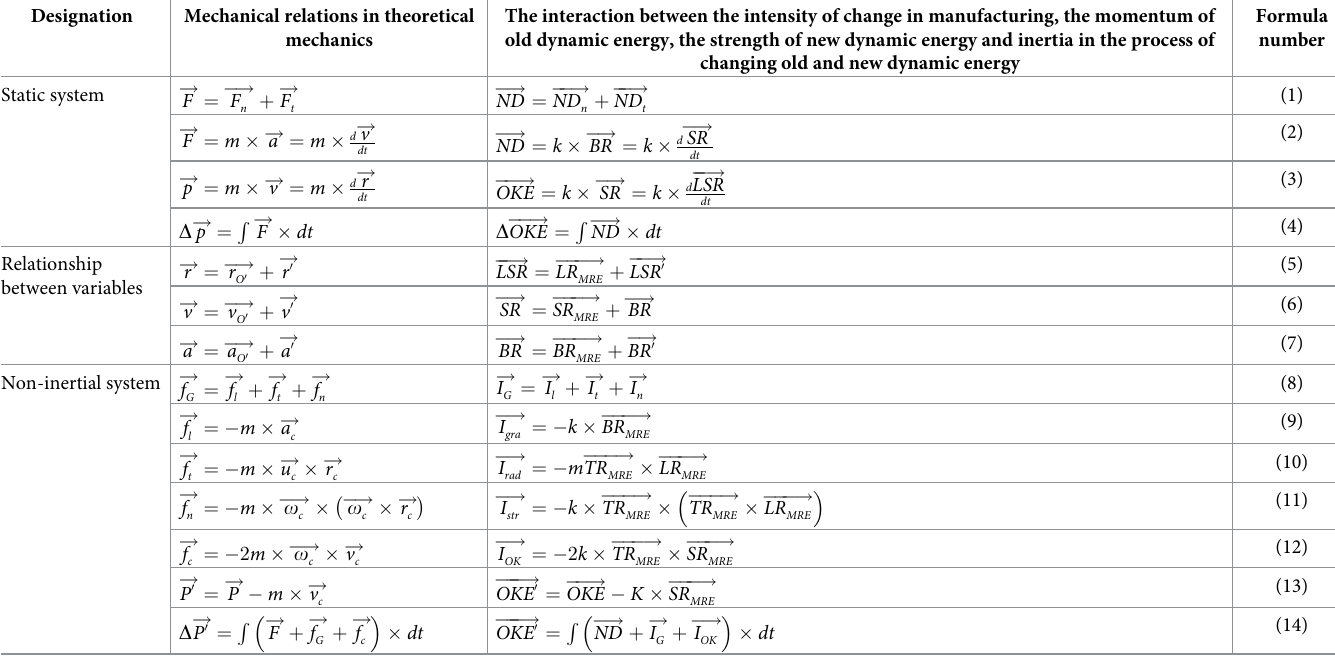
Table 2. Interaction relationship between variables in the process of green transformation of manufacturing. The interaction between the intensity of change in manufacturing, the momentum of old dynamic energy, the strength of new dynamic energy and inertia in the process